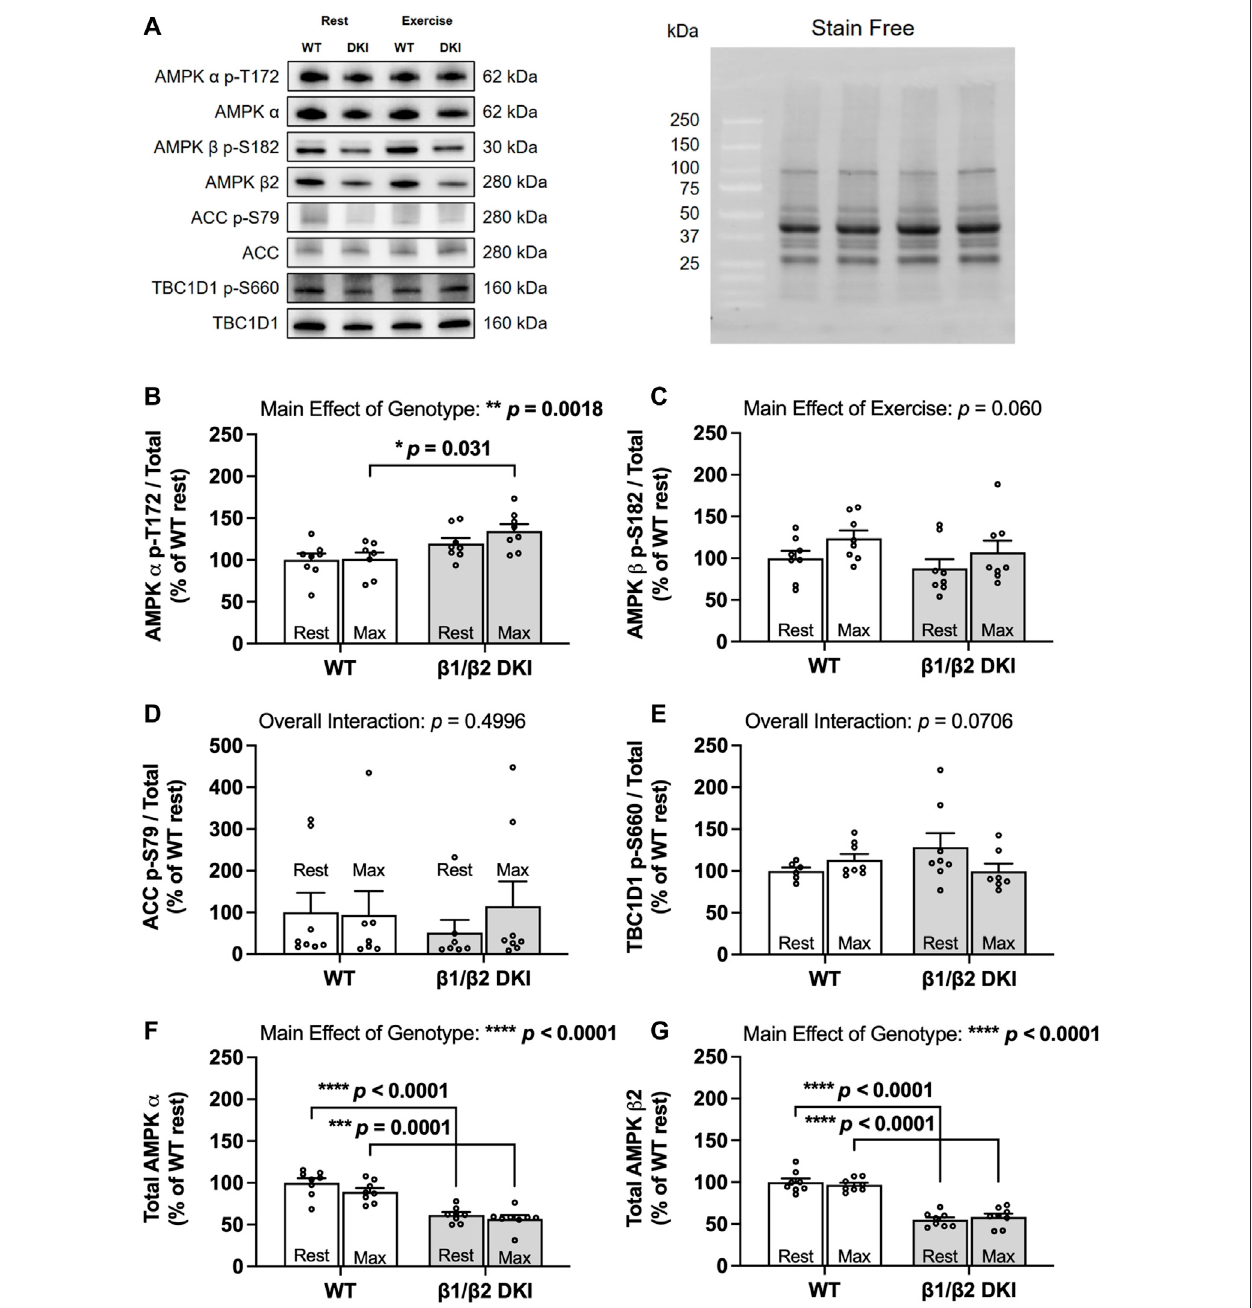
FIGURE7| DKImicehavereducedskeletalmuscleAMPK α and β 2contentbutintactAMPK,ACCandTBC1D1signaling inresponsetoamaximalrunningtestat a 5 ° incline versus WT. Skeletal muscles were collected from rested and maximally exercised male WT and DKI mice, and phosphorylation of AMPK and downstream substrates was assessed using Western blotting. (A) Representative immunoblots of p-T172 and total AMPK, p-S182 and total AMPK β , p-S79 and total acetyl-CoA carboxylase (ACC) and p-S660 and total TBC1 domain family member 1 (TBC1D1) with representative stain free image. Quanti fi ed relative (B) AMPK p-T172, (C) AMPK β p-S182, (D) ACC p-S79, and (E) TBC1D1 p-S660; (F) Total AMPK α ; (G) Total AMPK β . Male mice, 17 – 20 weeks, n = 6 – 8. * p < 0.05, ** p < 0.01, *** p < 0.001, **** p < 0.0001.